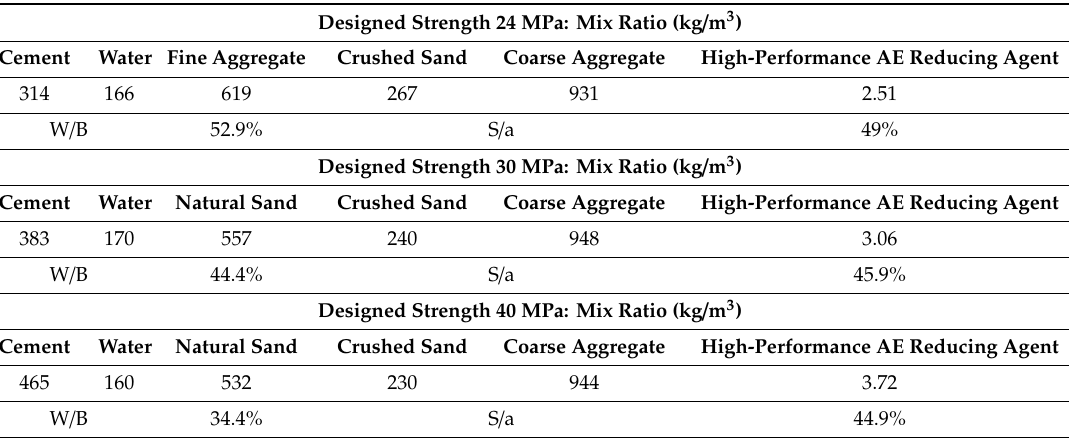
Figure 1. Concrete curing and concrete cylinder mold. Table 1. Mix ratio of concrete